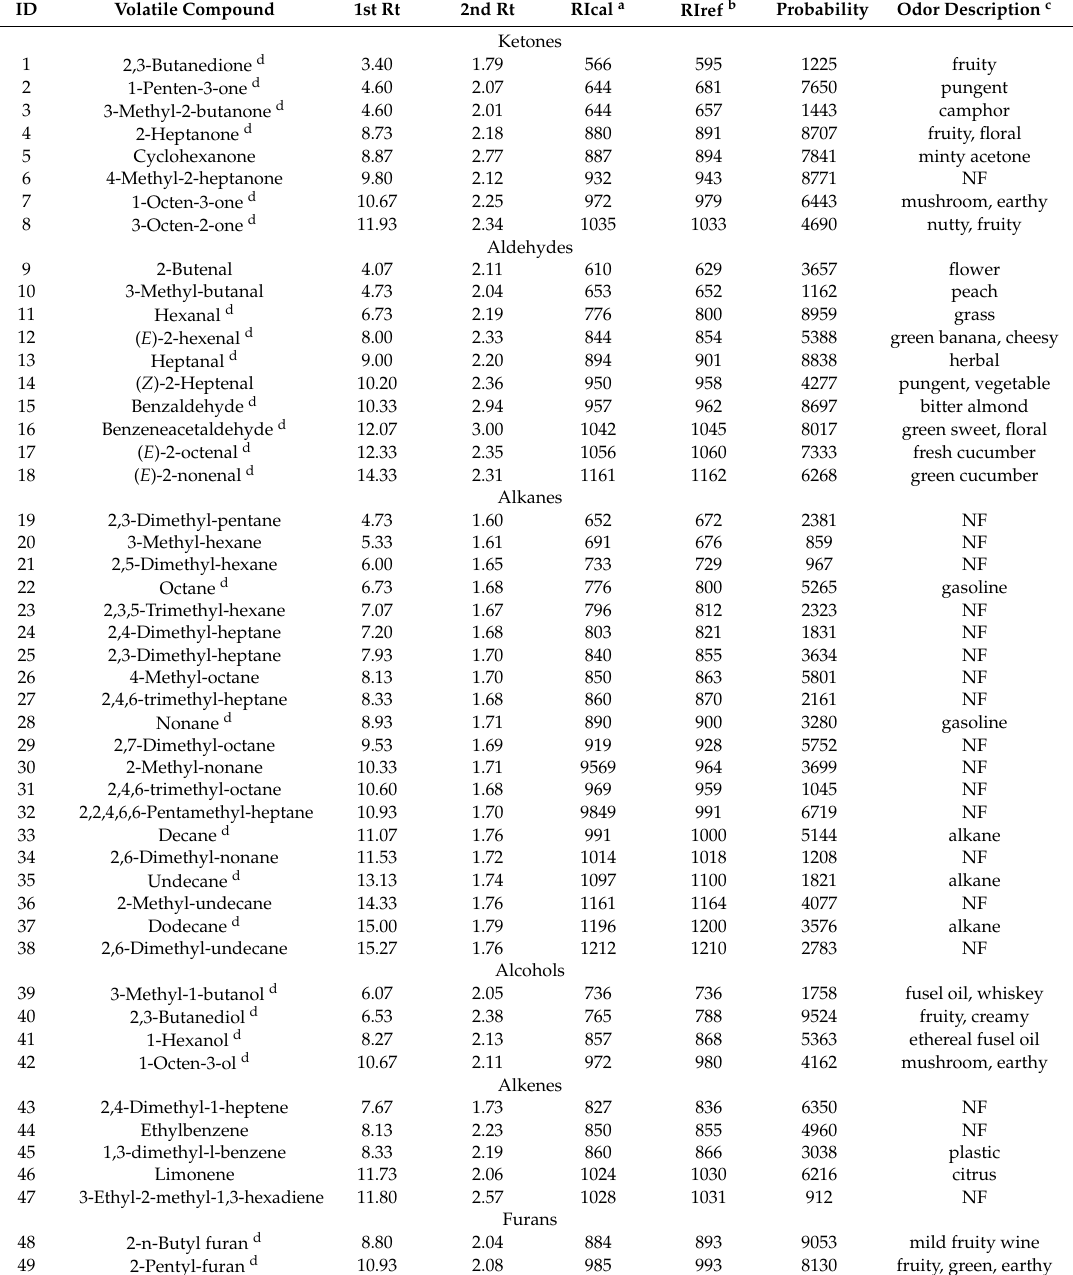
Table 1. Di ff erential volatile compounds putatively identified during germination of the foxtail